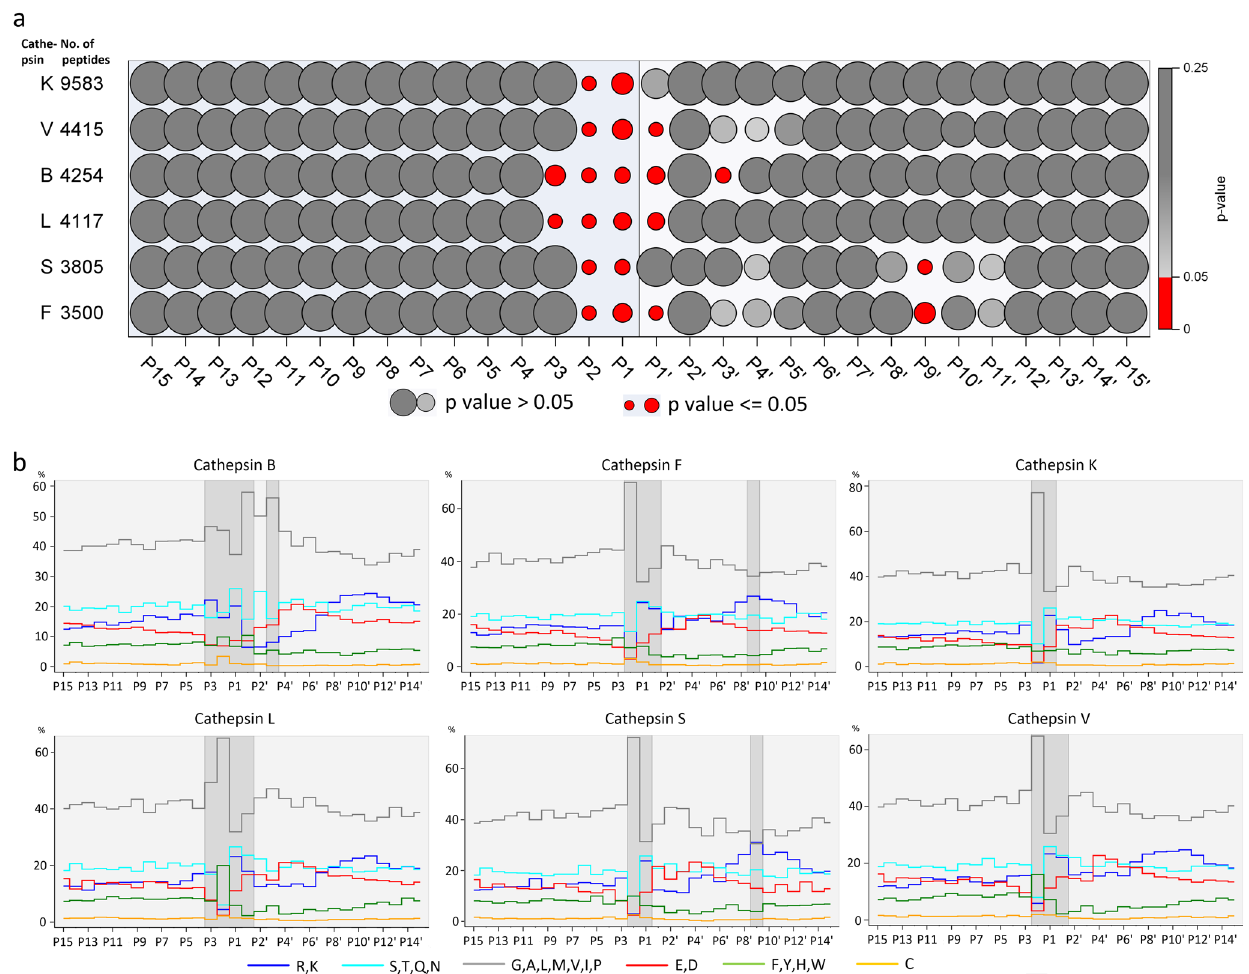
Fig. 2 Heterogeneous positions indicate speci fi city positions. a Normality of distributions. P -values for normality of distributions of residues at positions from P15 to P15 ′ (columns) for each cathepsin (rows) are indicated by the size of circles. The red and grey circles present p-values equal to or less than 0.05 (non-normal), larger than 0.05 and equal to 1.00 (normal), respectively. b Pro fi les of amino acid residue types. The amino acid residues were classi fi ed into 6 groups with share of each presented by a colored step chart: positively charged LYS, ARG (blue), neutral hydrophilic SER, THR, GLN, ASN (cyan), hydrophobic GLY, ALA, LEU, MET, VAL, ILE, PRO (light grey), negatively charged ASP, GLU (red), aromatic PHE, HIS, TYR, TRP (green), and CYS (yellow). The positions in the non-normal distributions of amino acid residues are